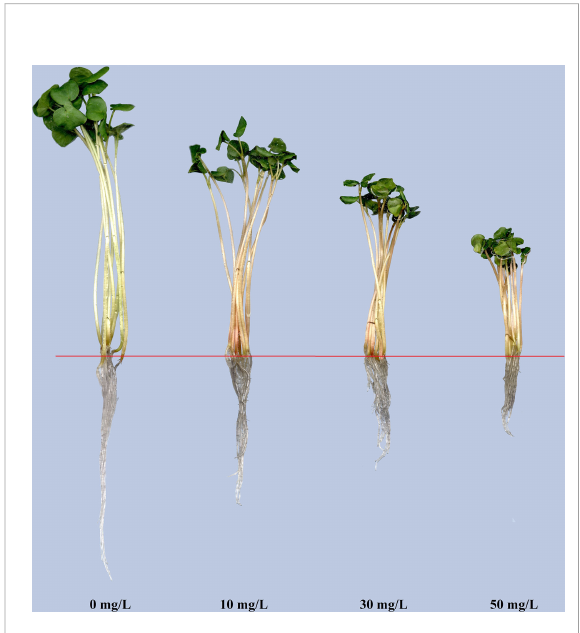
FIGURE 1 The Tartary buckwheat seedling under cadmium stress of various concentrations for 7-day